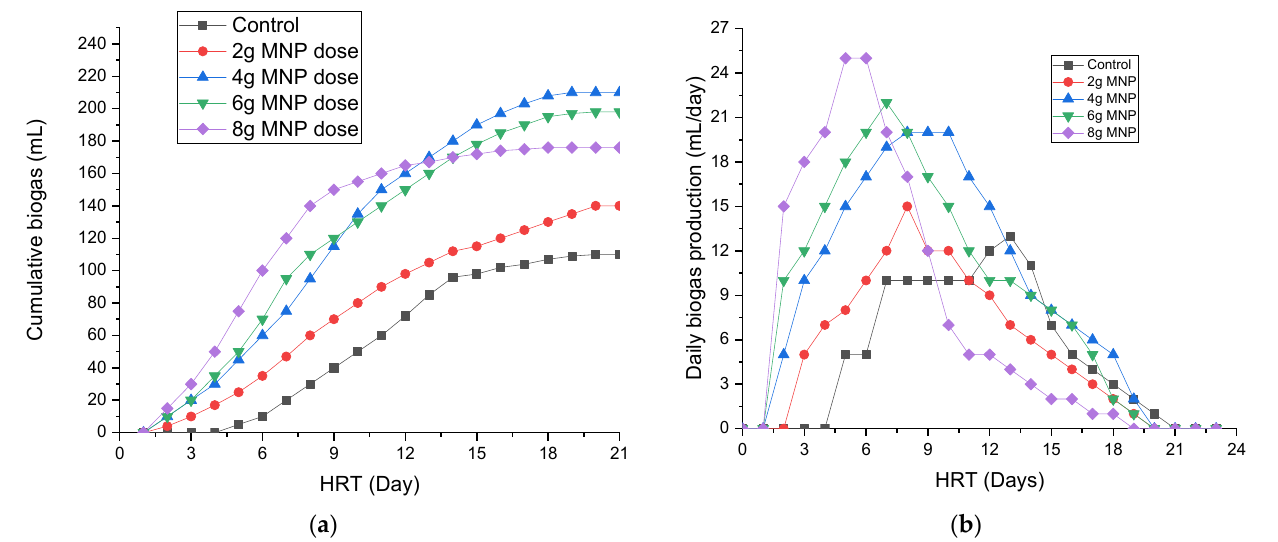
Figure 3. E ff ect of magnetite load on ( a ) cumulative biogas for the duration of AD; ( b ) daily biogas production.